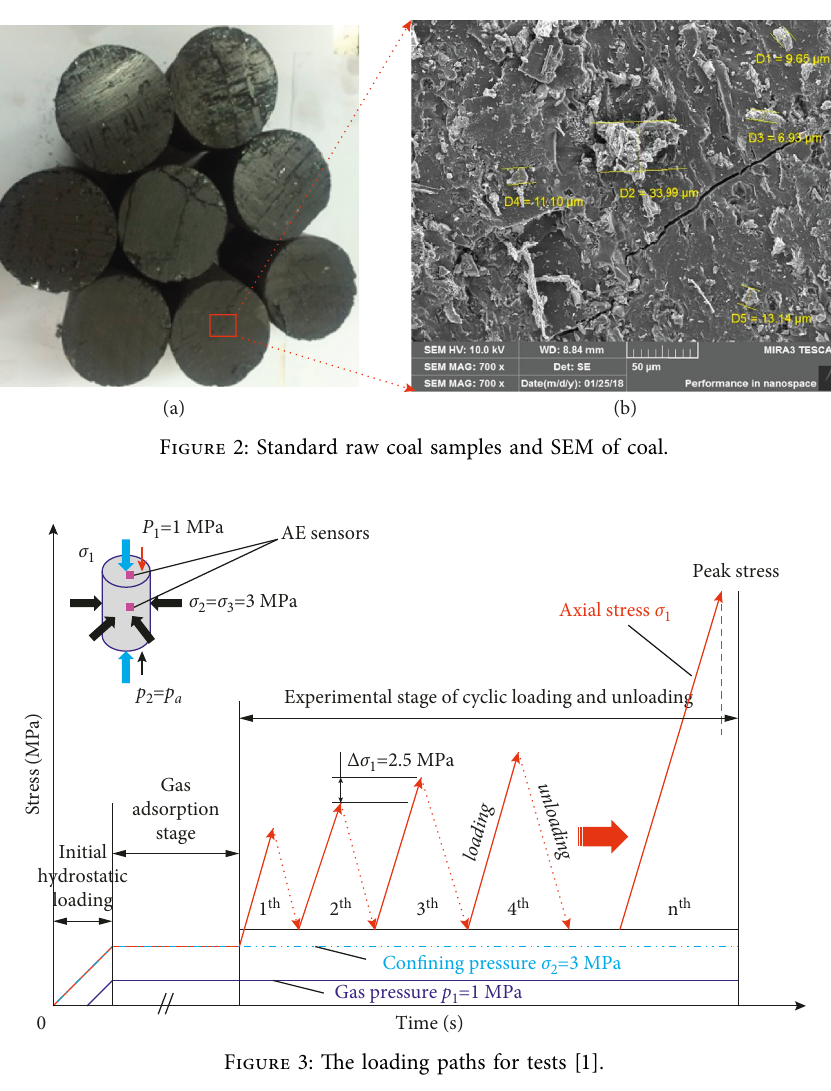
Figure 3: The loading paths for tests [1].